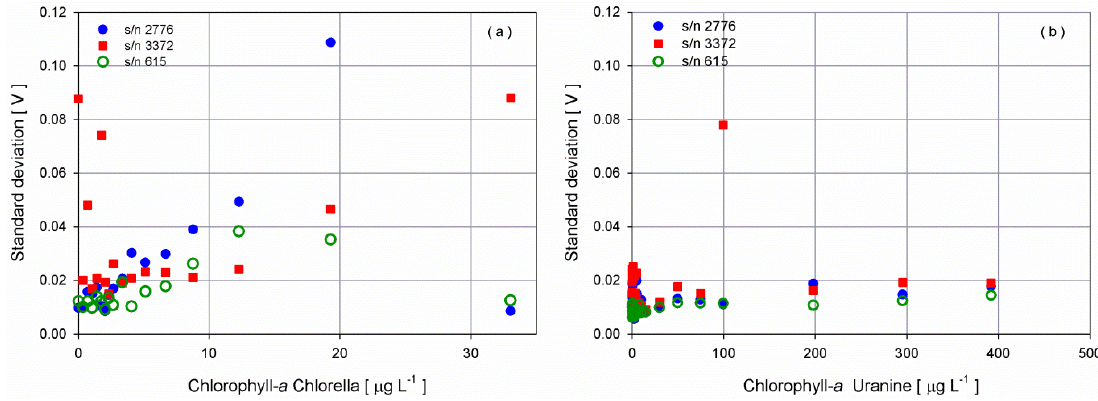
Figure 5. Noise level in terms of standard deviation of the fluorometers’ response as the concentration of ( a ) Chlorella and ( b ) Uranine increases.